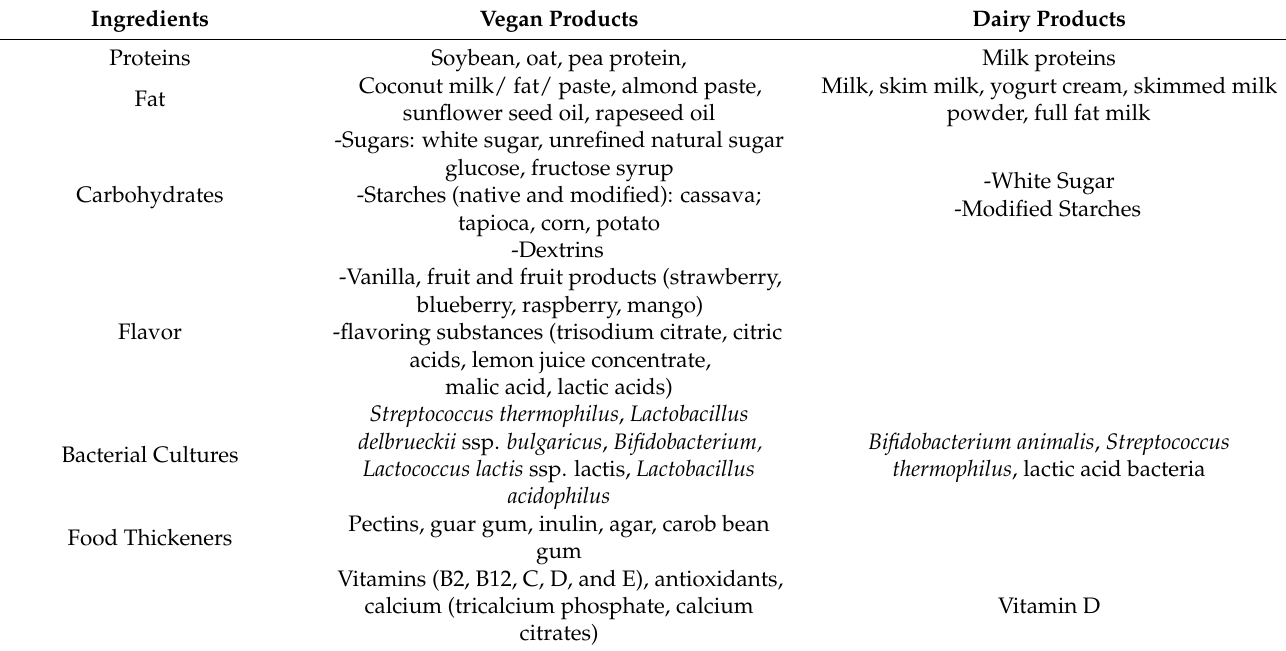
Figure 1. Nutritional profile of vegan alternatives to yogurt (n = 182) vs. natural dairy yogurt (n = 86). The box-plot legend: the box is limited by the lower (Q1 = 25th) and upper (Q3 = 75th) quartile; the median is the horizontal line dividing the box; whiskers above and below the box indicate the 10th and 90th percentiles; outliers are the points outside the quartile 10–90th percentiles. *: p < 0.05, ***: p < 0.001, ns: non-significant ( p > 0.05). Table 2. List of ingredients used to make dairy yogurt and their vegan